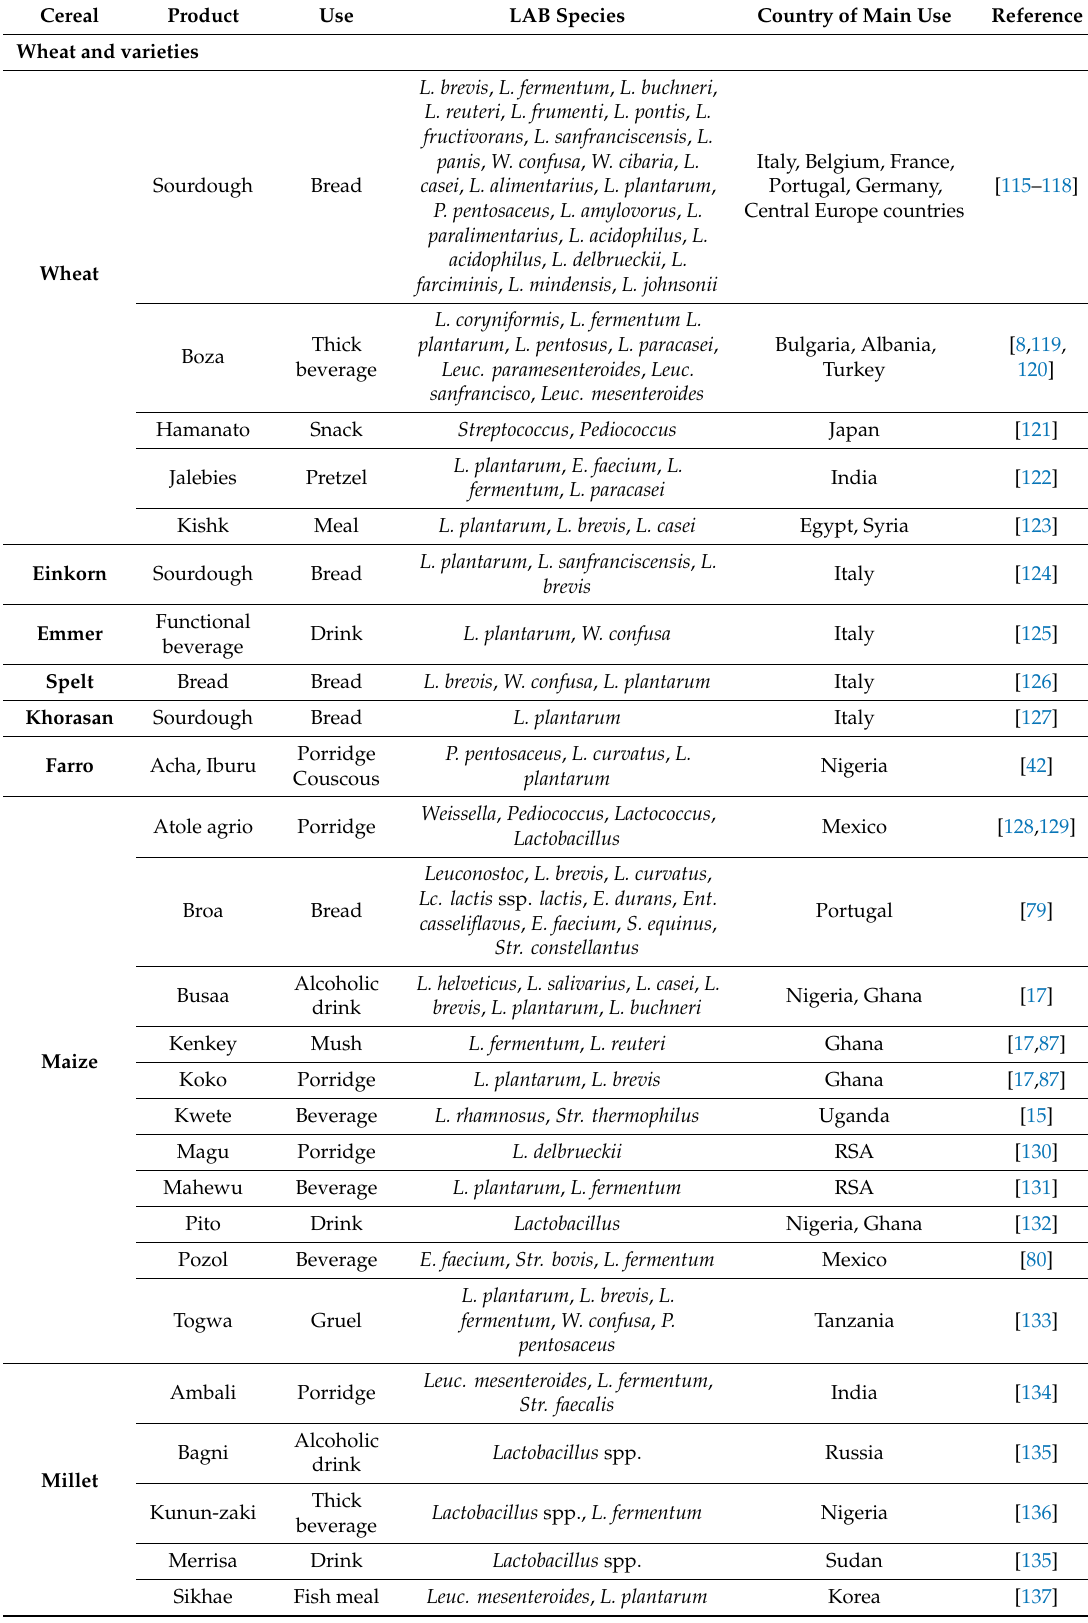
Table 2. The most popular foods and beverages around the world obtained by lactic acid fermentation of cereals and